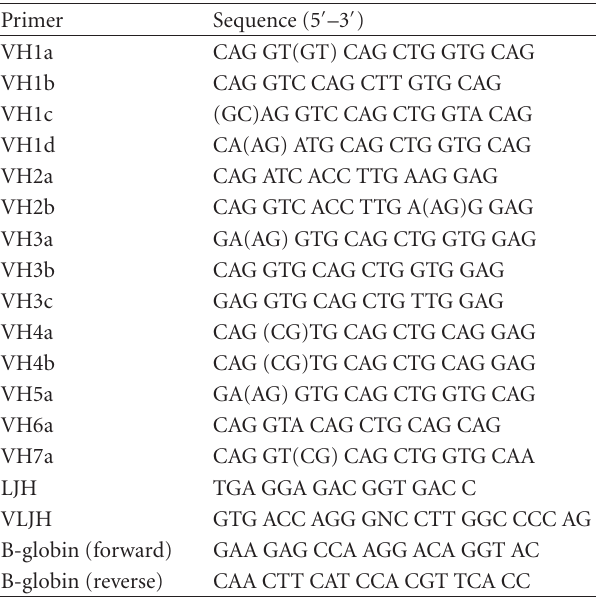
Table 2: Primers